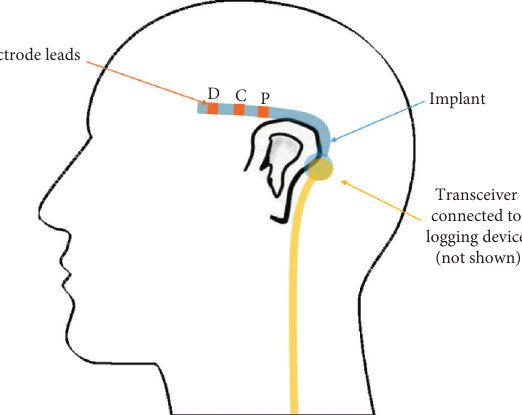
Figure 1: An illustration of the approximate position of the implanted electrode (blue) with the individual leads highlighted. The transceiver from the external logging device (orange) must be attached to the skin near the implanted electrode using double- sided glue